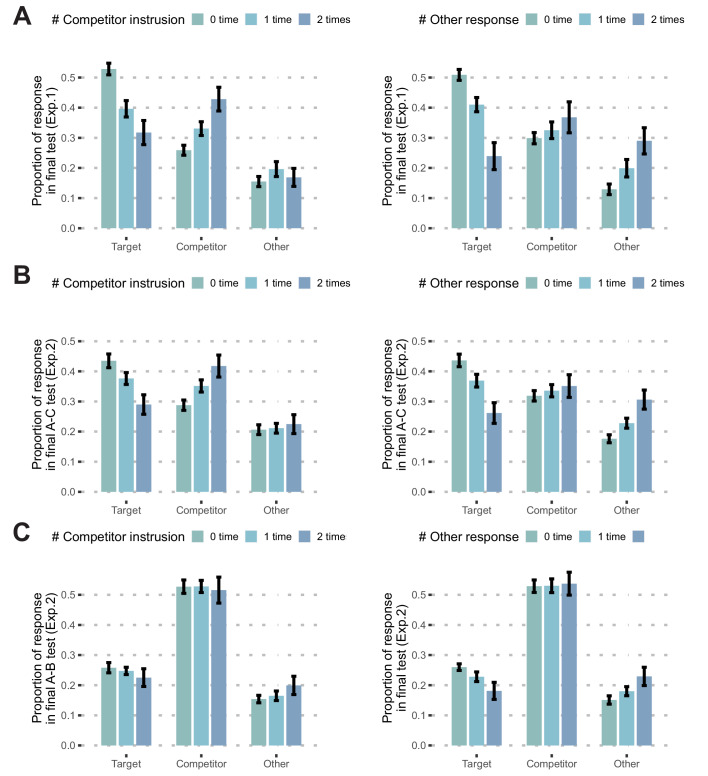
Incorrect responses during updating and memory performance during the final test.(A) Proportion of responses during the final test in Exp. 1 by the pair’s learning history during updating. The left panel shows that pairs with more competitor intrusions had fewer target responses (2 times vs 0 times, t(18) = −4.07, p<0.001), more competitor responses (t(18) = 4.06, p<0.001), and comparable 'other' responses (t(18) = 0.55, p=0.59) during the final memory test. For the number of 'other' responses (right panel), pairs with more 'other' responses during updating had fewer target responses (t(18) = −5.86, p<0.001), more 'other' responses (t(18) = 3.85, p=0.001), and comparable competitor responses (t(18) = 1.38, p=0.18) during the final test. There were more A-B intrusions than 'other' responses during the final test (t(18) = 4.47, p<0.001), even when the number of responses during updating was matched, suggesting strong A-B interference. (B) Proportion of responses during the final A-C memory test in Exp. 2. The results replicated those of Exp. 1. A greater number of competitor intrusions was related to fewer target responses (t(45) = −4.24, p<0.001), more competitor responses (t(45) = 3.79, p<0.001), and comparable 'other' responses (t(45) = 0.52, p=0.60) during the final A-C memory test. Again, a greater number of 'other' responses was related to fewer target responses (t(45) = −4.63, p<0.001), more 'other' responses (t(45) = 3.85, p<0.001), and comparable competitor responses (t(45) = 0.88, p=0.38) during the final A-C memory test. There were many more A-B intrusions than 'other' responses during the final test (t(45) = 5.46, p<0.001). (C) Proportion of responses during the final A-B memory test in Exp. 2. In terms of the memory for A-B pairs, neither the number of competitor intrusions nor that of 'other' responses during updating was related to A-B memory performance (competitor intrusions: t(45) = −0.25, p=0.80; 'other' responses: t(45) = 0.24, p=0.81). Error bars indicate within-subject standard error.